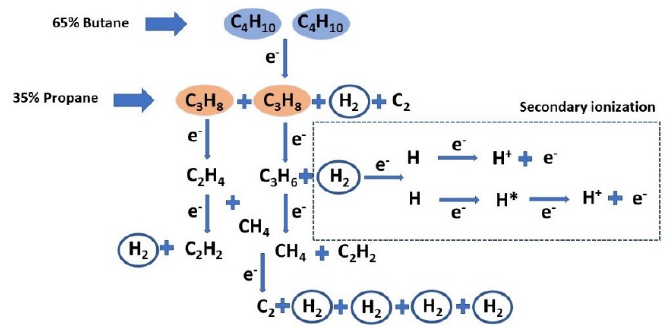
Figure 8. Scheme of the dissociation of C 4 H 10 /C 3 H 8 molecules by electron collisions. The detection of N 2 , NH, CO 2 , CO, and CN bands confirmed the existence of nitrogen and oxygen in the discharge tube. The reactions of the oxygen, hydrogen, and nitrogen of air with the carbon produced in the LPG dissociation explain the detected species [16,19].